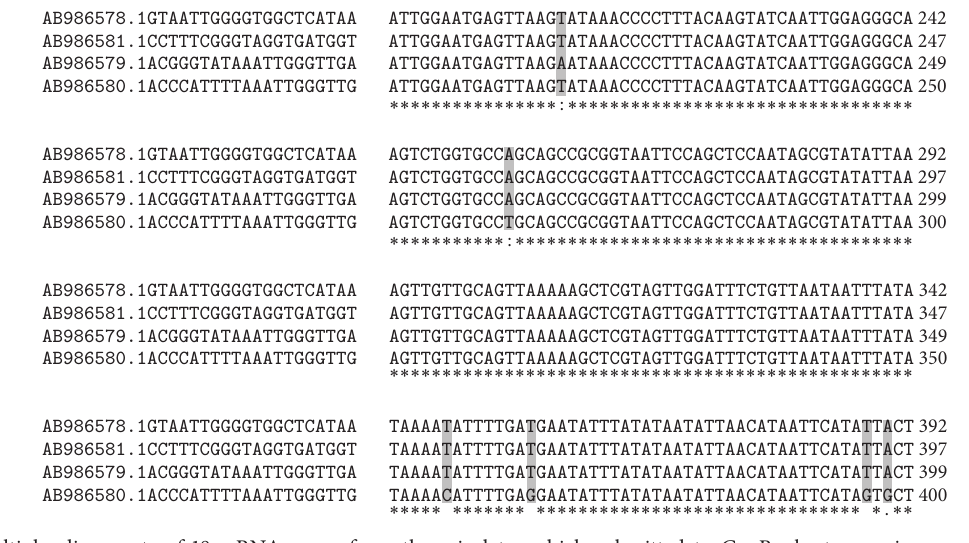
Figure 3: Multiple alignments of 18s rRNA genes from three isolates which submitted to GenBank at accession numbers AB986579 , AB986580 , and AB986581 . Asterisks ( ∗ ) show identical